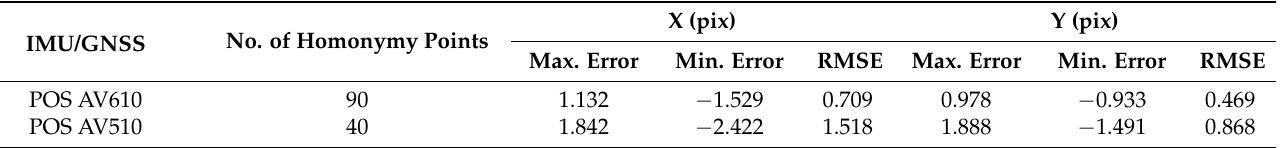
Table 17. Stitching error of EA-unstable-4 (left-middle